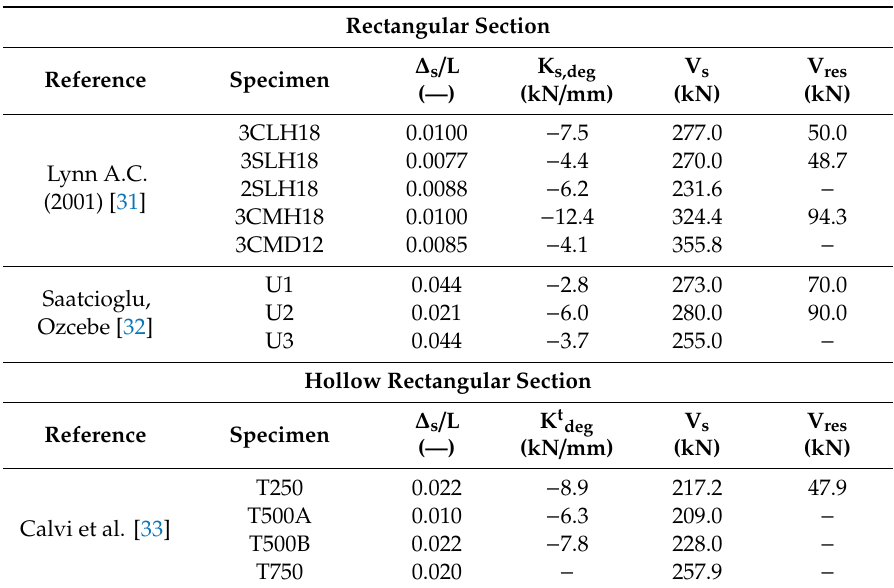
Table 2. Experimental values needed for the calibration of the shear spring (Figure